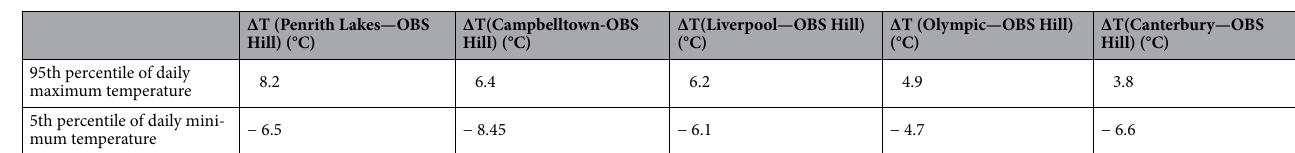
Table 1. Threshold temperatures for the upper 5% ΔT (UO) and lowest 5% ΔT (UC) at all Sydney sites.